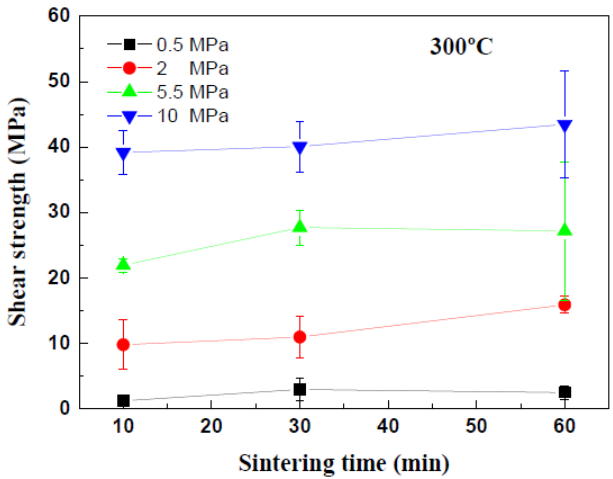
Figure 8. Variation of die shear strength with the sintering pressure and duration.